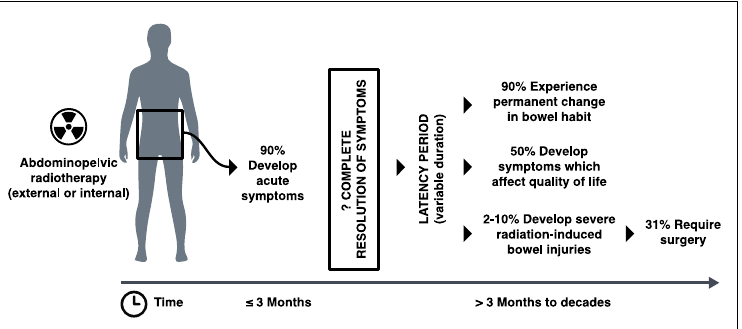
Figure 1. Clinical course of patients undergoing radiotherapy to abdominopelvic region and consequential development of radiation-induced bowel injury over time.